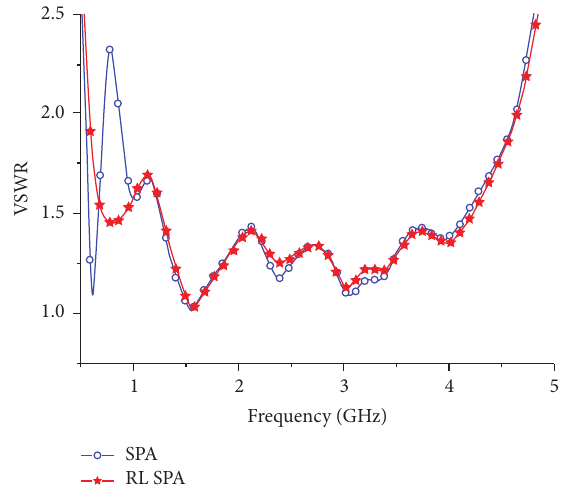
Figure 4: The VSWR of SPA and RLSPA.